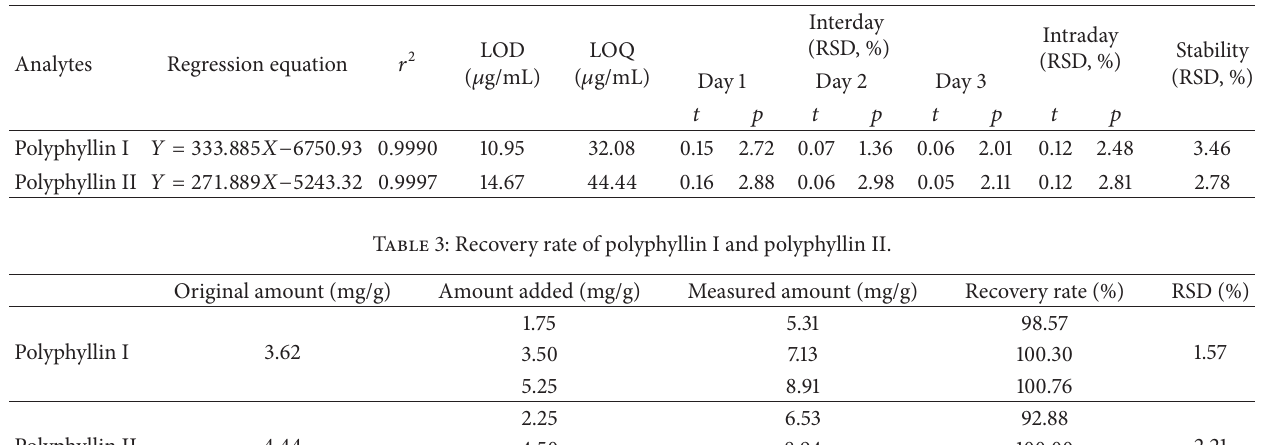
Table 2: Calibration curves, LOD, LOQ, intraday, and interday for polyphyllin I and polyphyllin II.